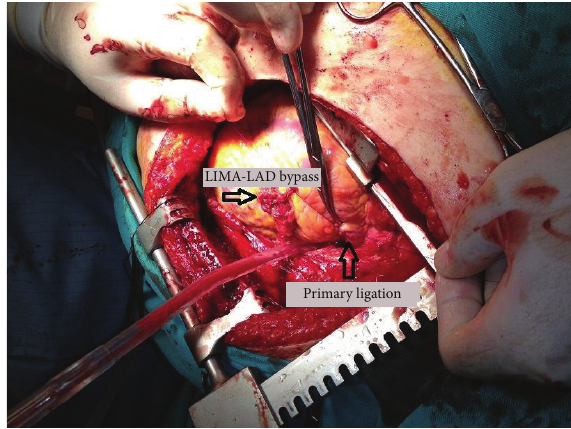
Figure 2: Coronary bypass and fistula ligation.